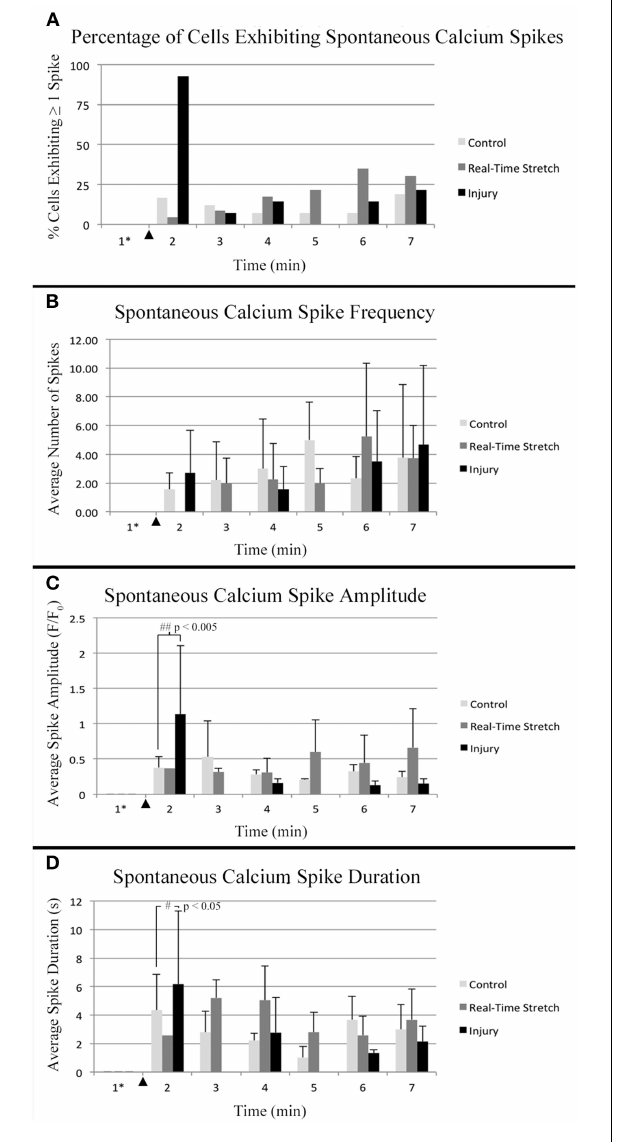
FIGURE 8 | Intracellular calcium flux. Quantified data from control neurons ( n = 42 , 8DIV), real-time stretched cells ( n = 11 , 11DIV), and stretch-injured cells ( n = 14 , 11DIV) was averaged over 1-min periods for analysis of trends associated with experimental perturbation. (A) The prevalence of spiking increased ubiquitously in injured cells at the time of injury. (B) The frequency of spikes, in spiking cells, tended to increase in all cells over time. (C) The amplitude of calcium spikes was significantly larger in injured cells at the time of injury than during subsequent spikes. (D) The duration of calcium spikes at the time of injury was significantly longer at the time of injury than in subsequent spikes. Graphs show mean ± standard deviation. (cid:2) Time of injury in injured cells/start of real-time stretch in stretch-grown cells. * Cells that spiked during the first minute of recordings were excluded from analysis.